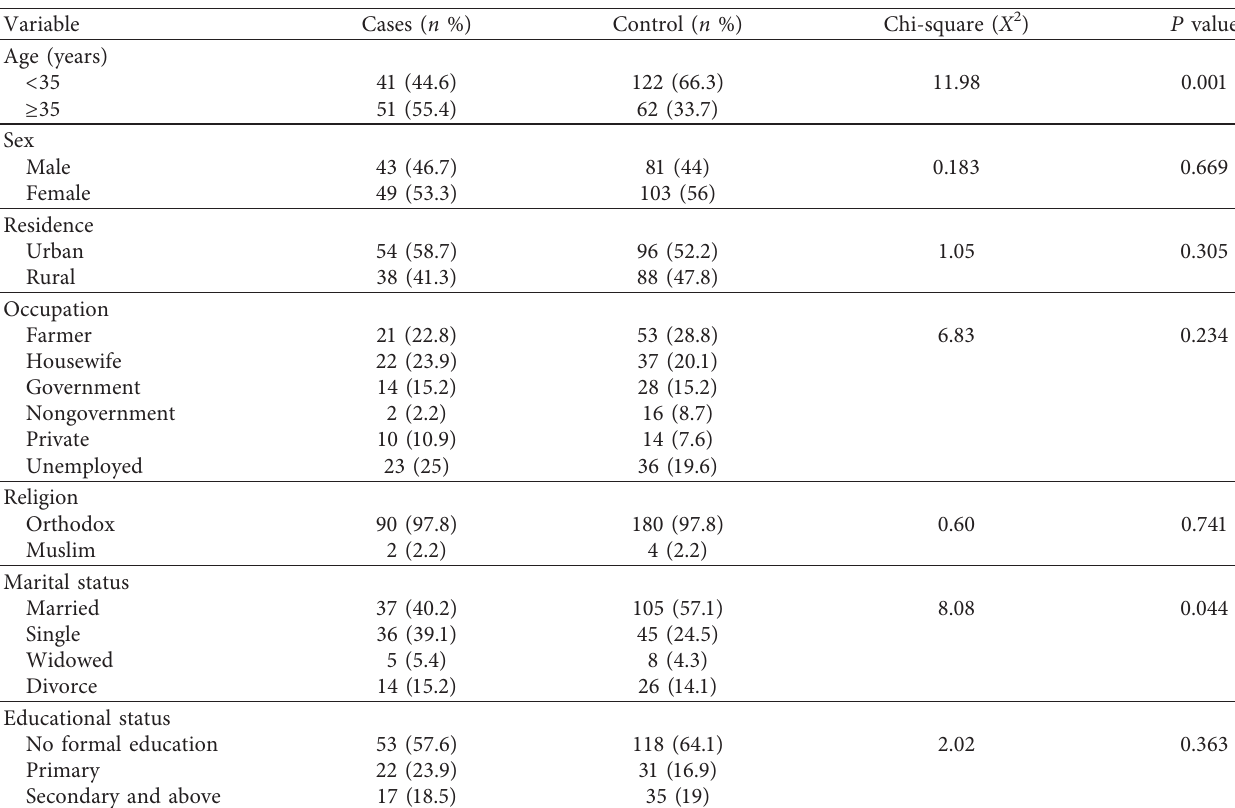
Table 1: Sociodemographic characteristics of PLHIV on ARTat Waghimra zone health institution ARTclinic, Northern Ethiopia, in 2019 ( n � 276).